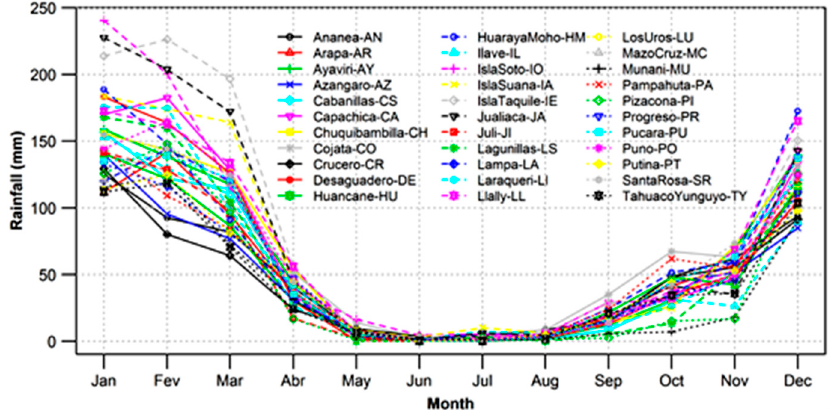
Figure 2. Average monthly gauged rainfall distribution of selected stations in the Lake Titicaca basin (from 2002 to